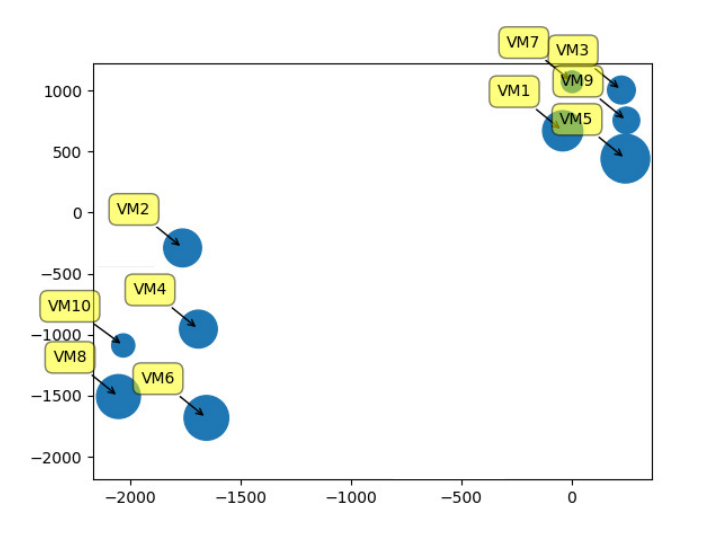
Figure 6. PCA-based dependency